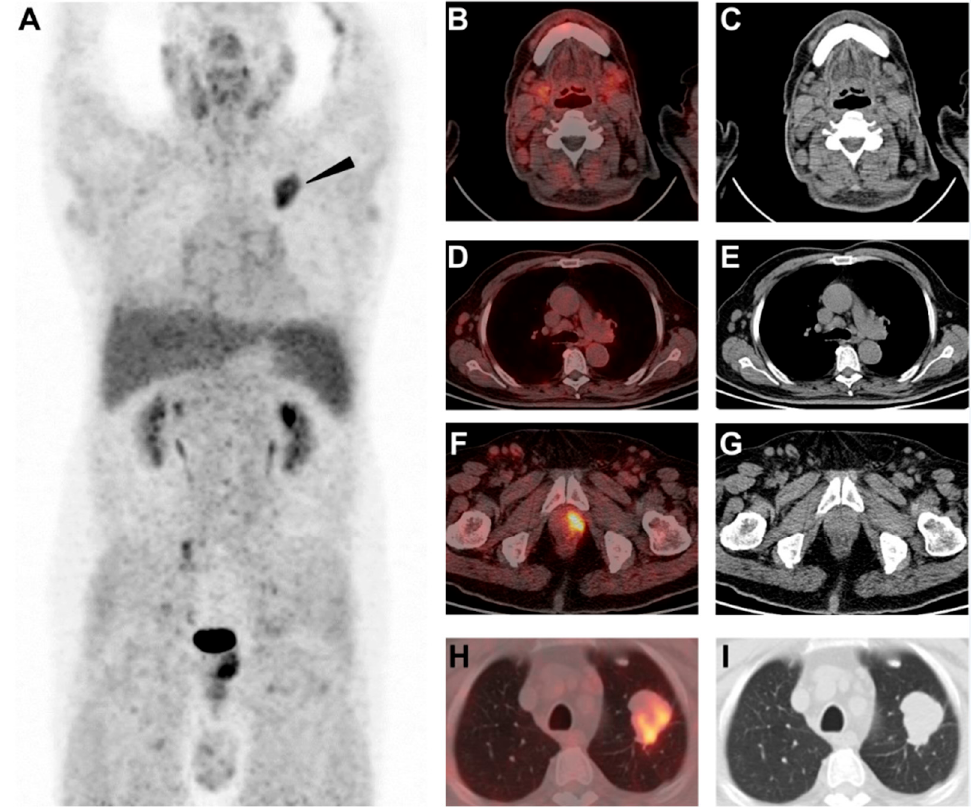
Figure 2. For further differentiation, he was included in a clinical trial of PET/CT with 68 Ga-labeled fibroblast activation protein inhibitor (FAPI) approved by the institutional review board in our hospital (zs-1810), and written informed consent was obtained from the patient. 68 Ga-FAPI is a recently introduced agent targeting cancer-associated fibroblasts (FAP) that overexpress in the stroma of various solid tumors [9–11]. However, hematological disease and certain types of inflammatory nodes (e.g., IgG4-related lymphadenopathy, rheumatoid disease) usually lack fibrosis (adapted from [12–15]). Based on this hypothesis, we thought 68 Ga-FAPI might help differentiate metastatic lesions and other etiologies in this patient. 68 Ga-FAPI PET/CT was performed three days after 18 F- FDG PET/CT. The MIP of 68 Ga-FAPI PET ( A ) and axial fusion and CT images ( B – G ) showed the previous hypermetabolic nodes were not avid for 68 Ga-FAPI (SUVmax 1.6), but the mass in the up- per left lung showed intense 68 Ga-FAPI uptake (( A ). arrowhead, SUVmax 6.4; ( H , I ), axial fusion and CT image, lung window). In addition, a FAPI-avid prostatic lesion was noted ( F – G , SUVmax 7.9). As expected, we consider the pulmonary mass avid for both FDG and 68 Ga-FAPI was metastatic from colon cancer, and the lymph nodes (FDG+/FAPI-) were possibly a hematological disorder, such as lymphoma. The accidentally detected lesion in the prostate (FDG-/FAPI+) might be prostate can- cer.